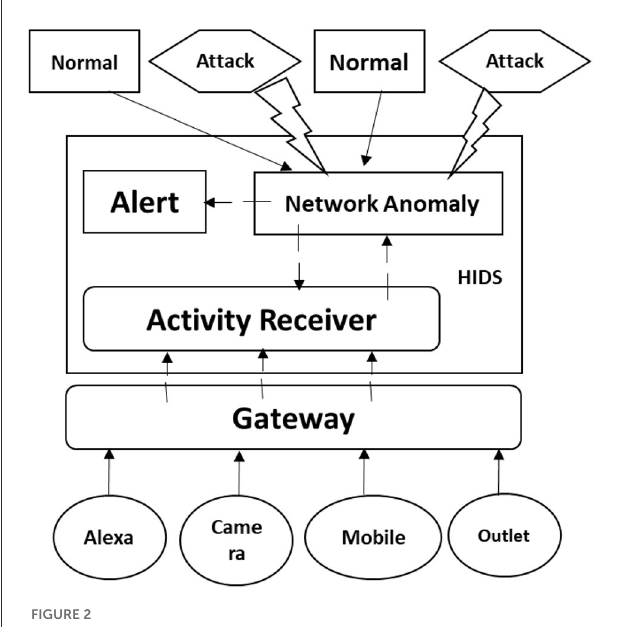
FIGURE2 The framework of our proposed HIDS